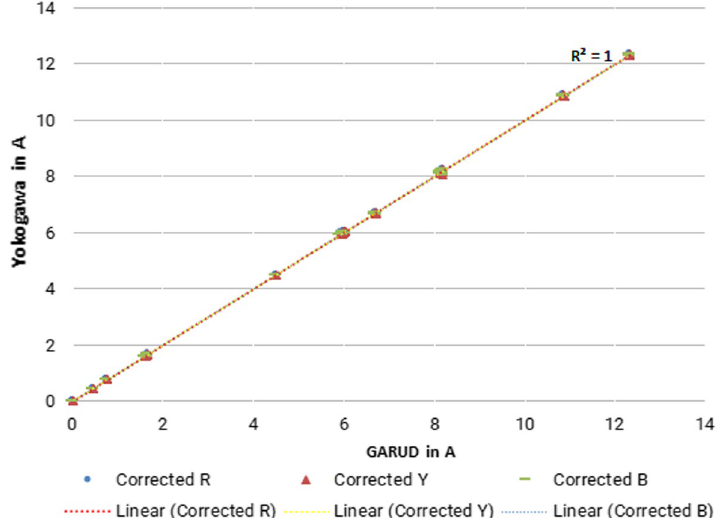
Fig. 7 Yokogawa (WT330) vs Garud with a correction